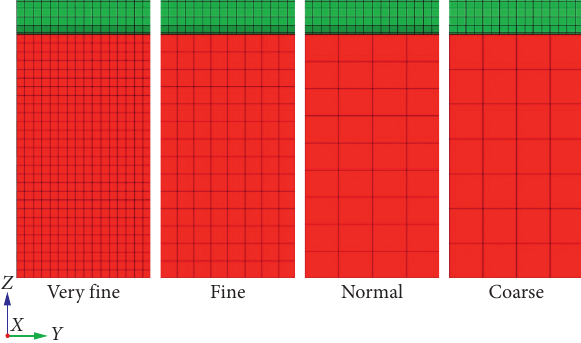
Figure 7: Mesh design for the CBIS model.